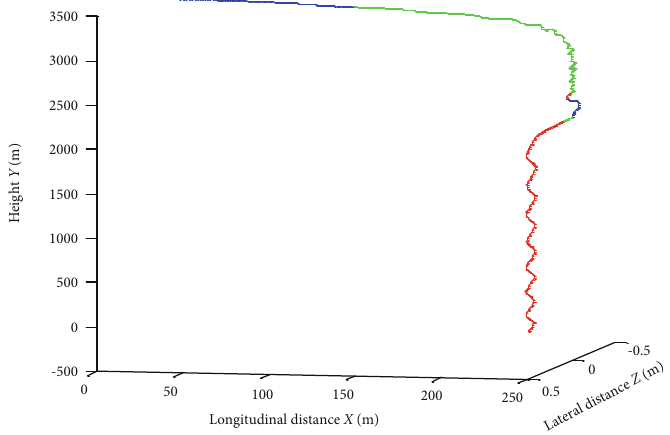
Figure 3: Three-dimensional trajectory curve.